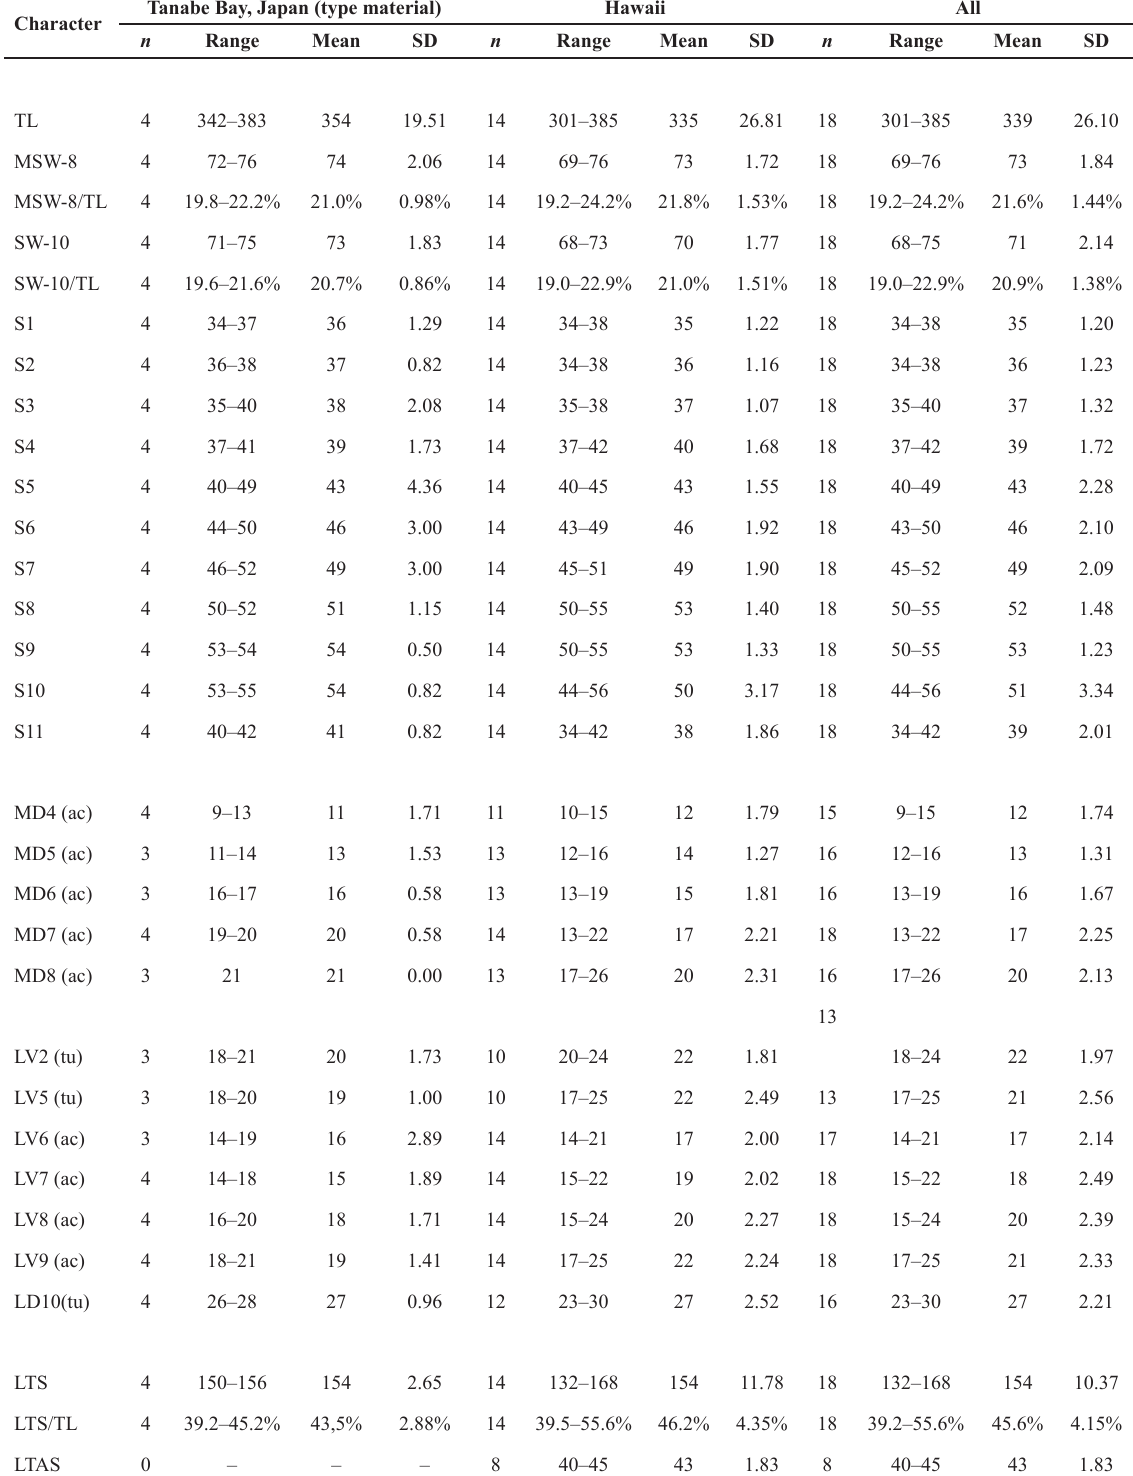
Table 11. Measurements from light microscopy for four Japanese type specimens and selected specimens from the Hawaiian population of Echinoderes sensibilis Adrianov et al ., 2002 (in µm), including number of measured specimens ( n ) and standard deviation